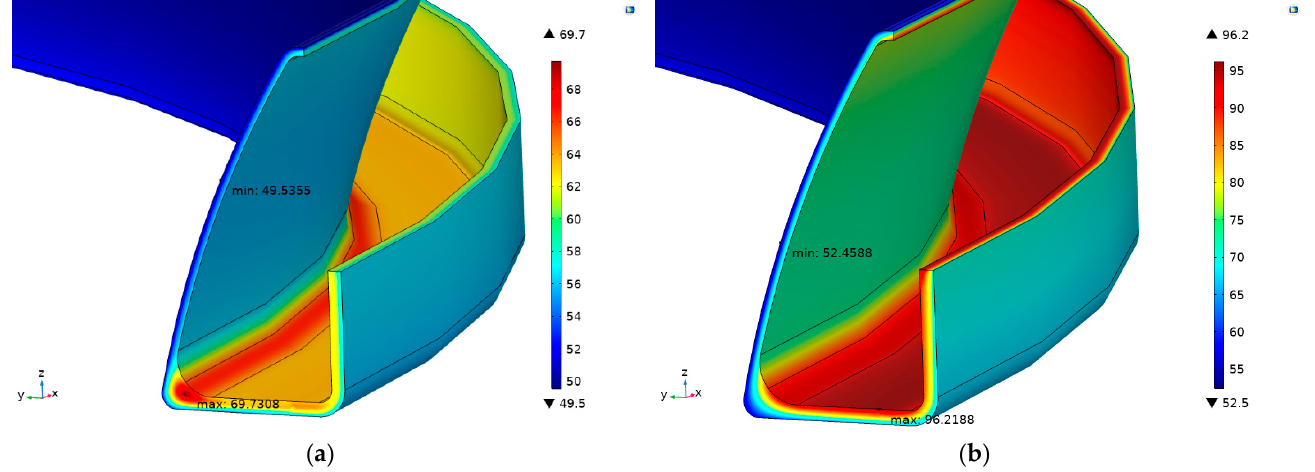
Figure 16. Temperature distribution within the part at the time when ∆ T is maximum for the cure at 60 °C ( a ) and 100 °C ( b ).